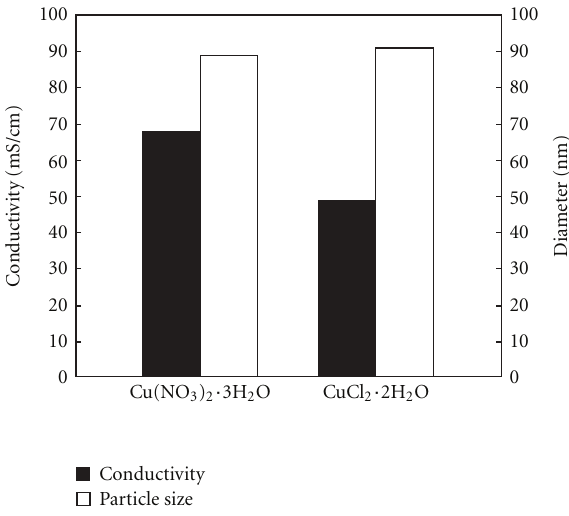
Figure 4: Conductivity of the solution and the size of the par- ticles produced for two di ff erent solutions when 0.3mol/dm 3 of Cu(NO 3 ) 2 · 3H 2 O and CuCl 2 · 2H 2 O used,